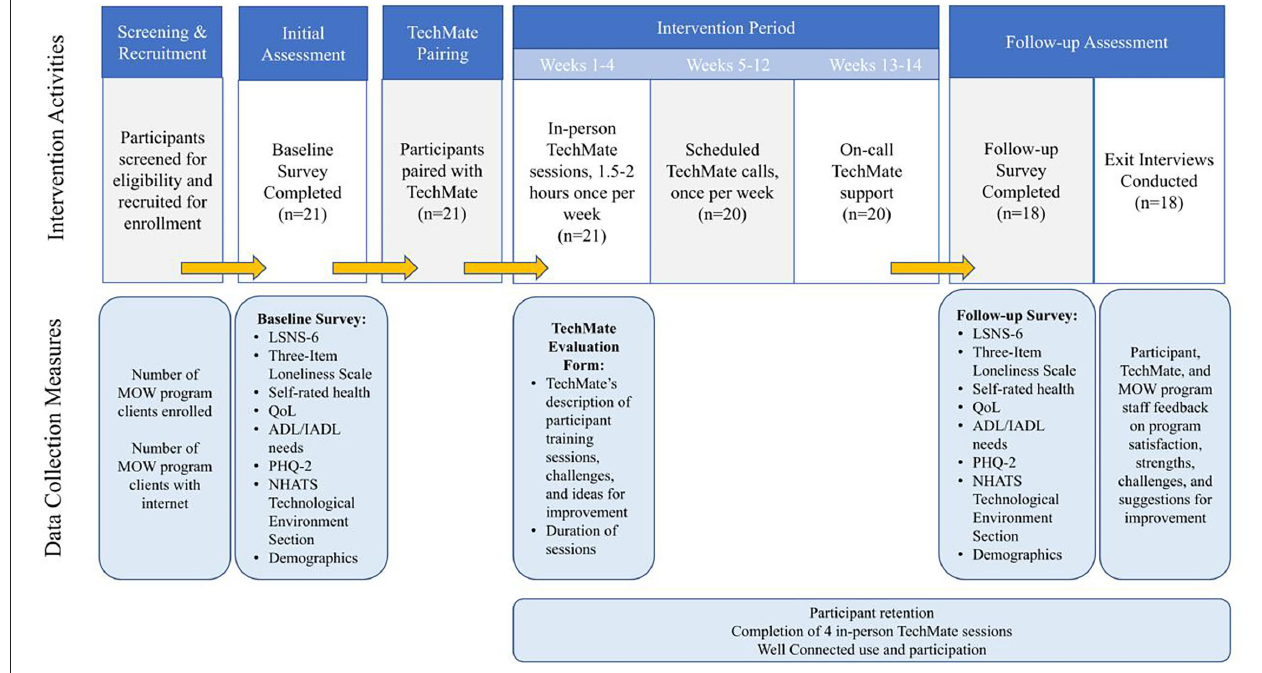
FIGURE 1 | Talking Tech intervention activities and